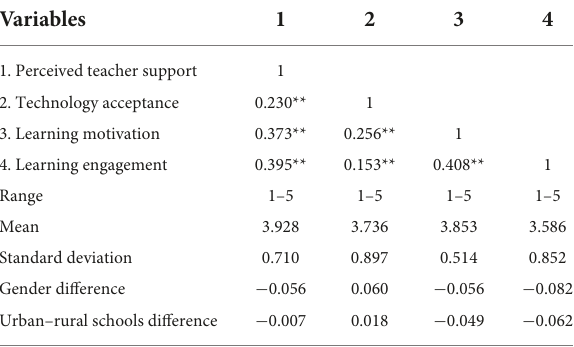
TABLE 2 Descriptive statistics and